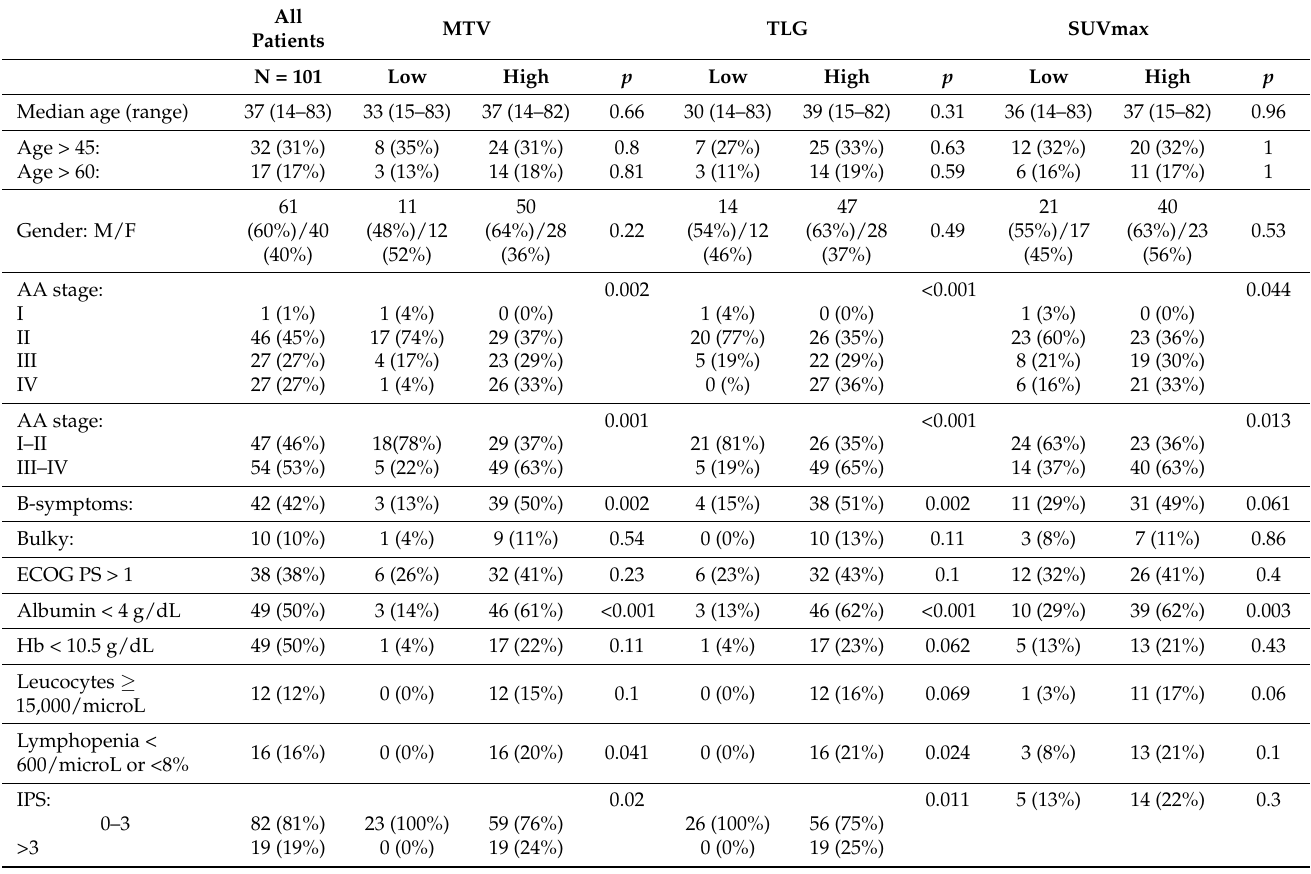
Table 3. Relationship between FDG PET/CT variables and main prognostic factors in